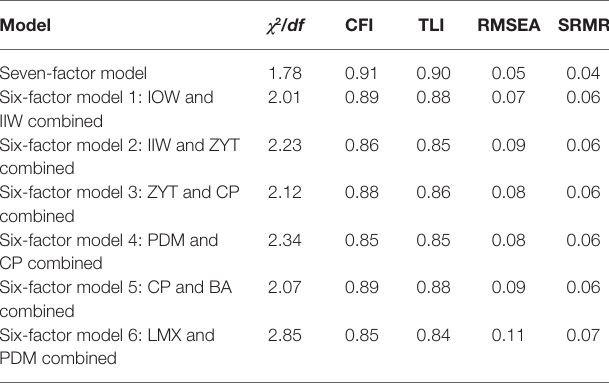
TABLE 1 | Results of confirmatory factor analysis for the measures of the variables studied.